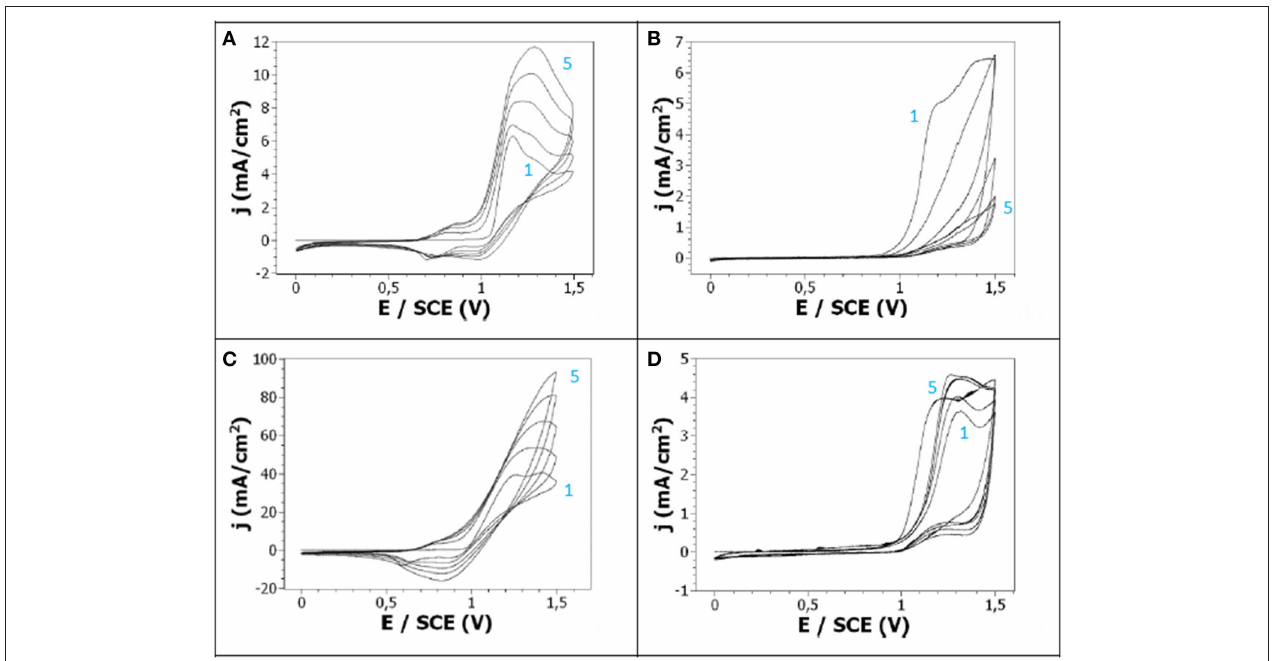
FIGURE 1 | Cyclic voltammetry at a Pt electrode of: (A) 10 − 2 M Cz + 0.1M LiClO 4 in ACN, (B) 10 − 2 M Cz + 0.1M LiClO 4 in DMF, (C) 10 − 1 M Cz + 0.1M LiClO 4 in ACN, (D) 10 − 3 M Cz + 0.1M LiClO 4 in ACN. Scan rate: 50